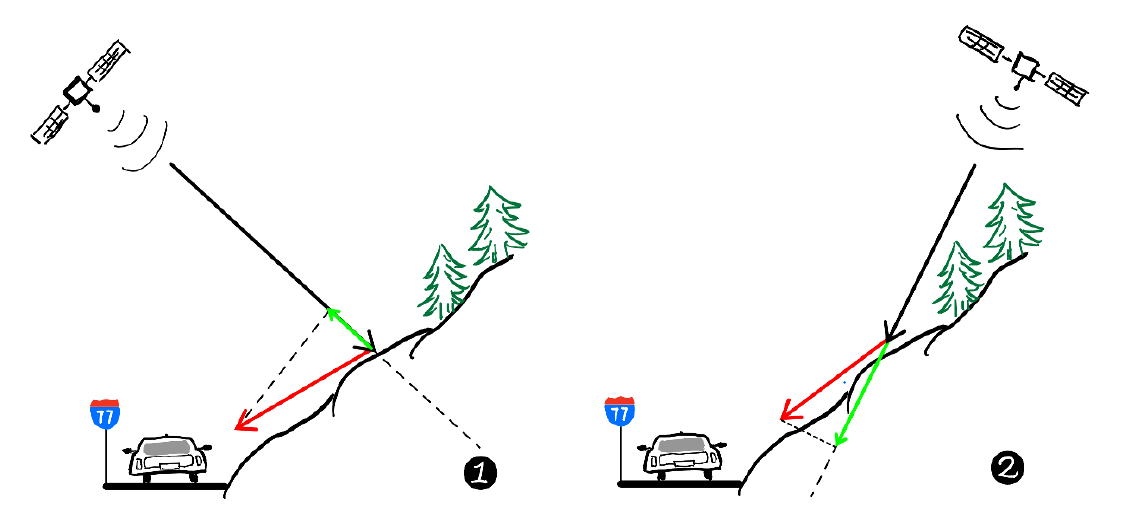
Figure 19. The relationship between the surface movement (red arrows) and what will be seen from the satellite (green arrows). The satellite can only measure the projection of the surface movement to the LoS direction (black